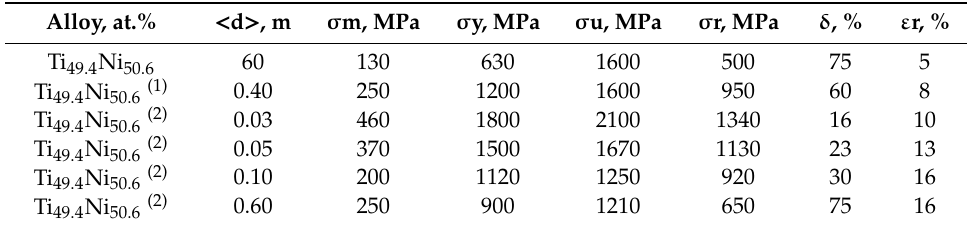
Table 9. Mechanical properties of high-purity alloys Ti 49.4 Ni 50.6 , quenched and subjected to ECAP (1), HPT (2) and